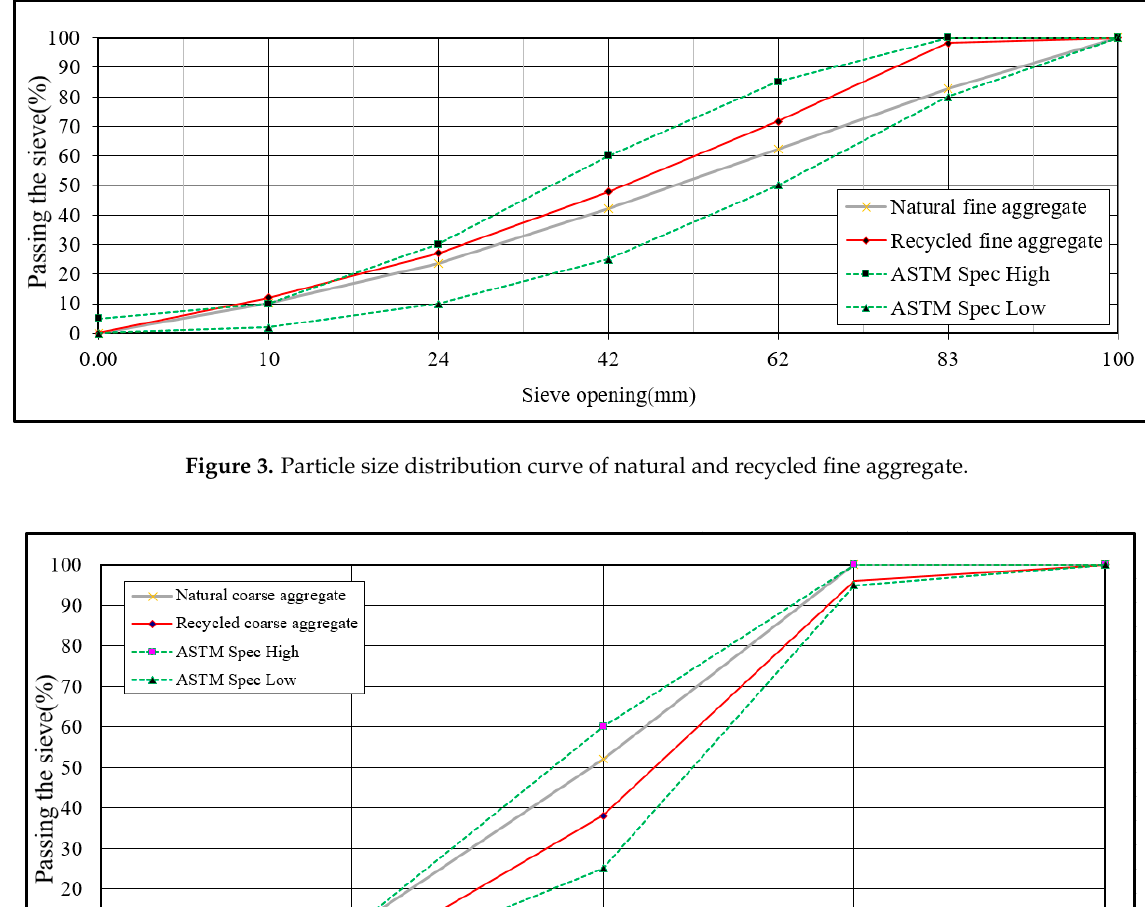
Figure 2. Appearance of recycled coarse aggregate.